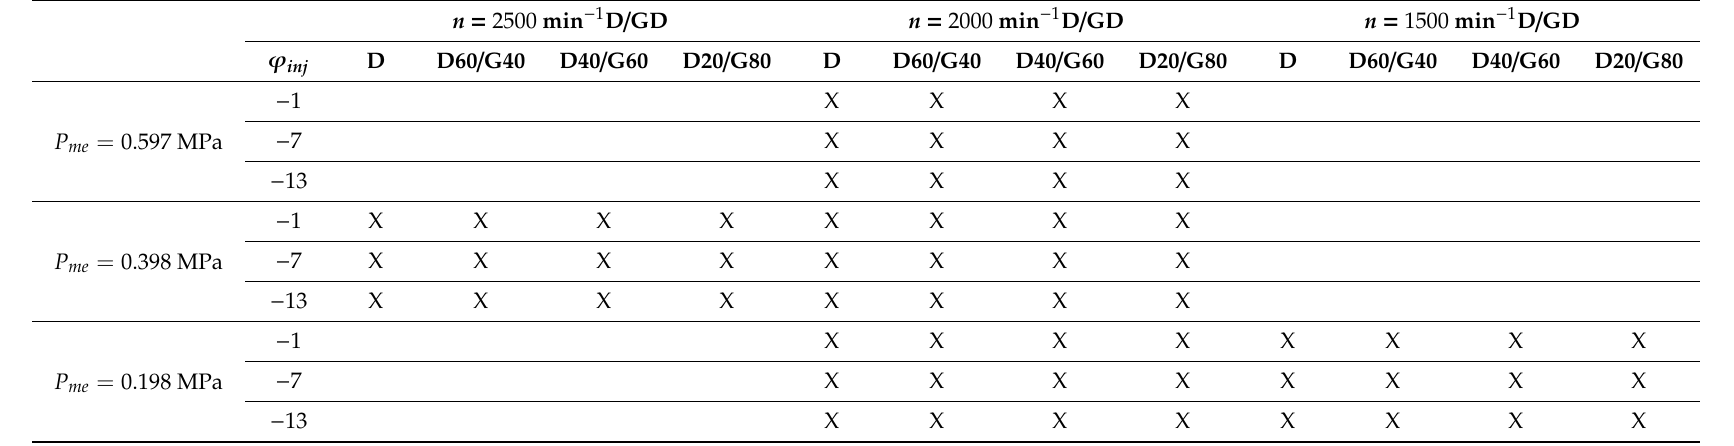
Table 7. Experiment execution